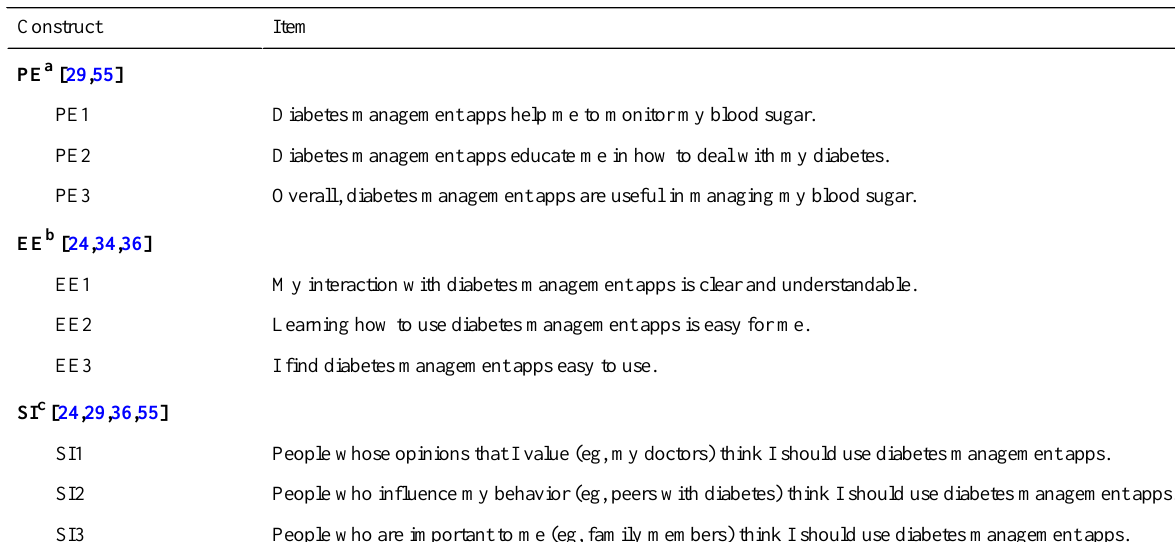
Table 2. Measurement items of the constructs.